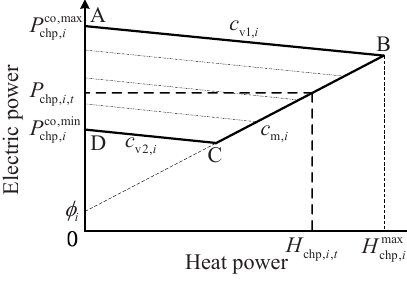
Figure 1. Electric and heat power characteristics of the CHP